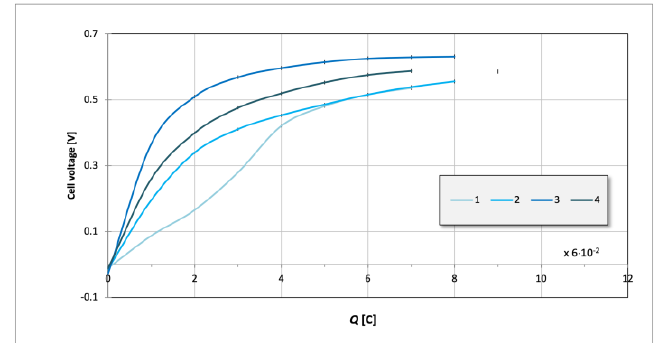
Figure 7. Influence of an anodic charge on the voltage of a half-cell with Cu-Ag (4% of Ag) electrode—influence on the catalytic activity of electrode (lines 1–4 corresponding with 1st, 2nd, 3rd, and 4th anodic charge).